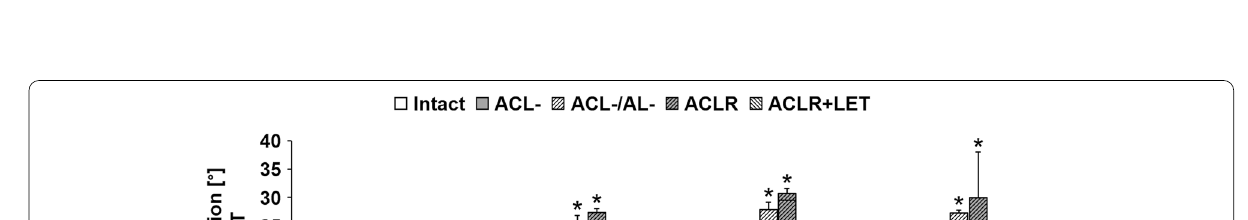
LET) for different angles of knee flexion. +